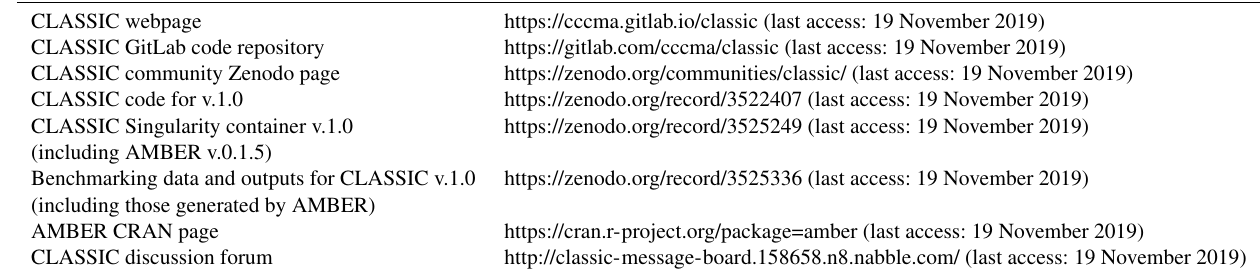
Figure 3. Locations of the 31 FLUXNET sites grouped by biome (Table 1). International Geosphere-Biosphere Programme (IGBP) land classification abbreviations used include evergreen broadleaf forest (EBF), evergreen needleleaf forest (ENF), savanna (SAV), deciduous broadleaf forest (DBF), grassland (GRA), cropland (CRO), open shrubland (OSH), closed shrubland (CSH), permanent wetland (WET), and deciduous needleleaf forest (DNF). Table 2. Summary table of CLASSIC resources. Resources that do not list a version number will be updated with the most recent versions over